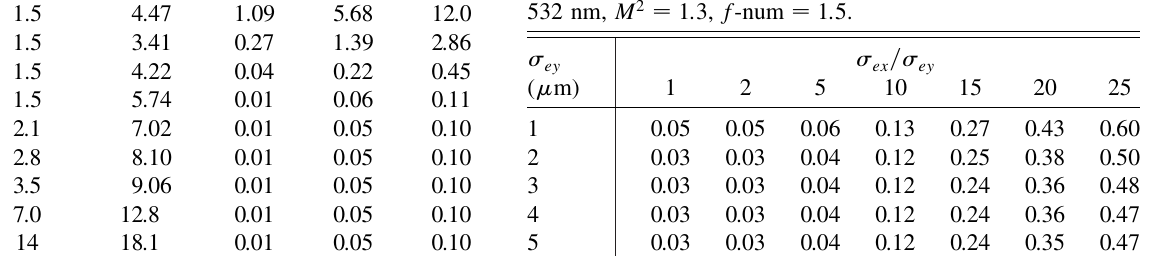
TABLE VIII. Errors for the scan of the horizontal dimension (cid:1) 1 (cid:3) m . The =(cid:2) (cid:2) for various aspect ratios (cid:2) when (cid:2) ex ex ey ey f -numbers are chosen so that the angular scanning range can be limited to 1 mrad; the f -number used is given by whichever is the greater of 1.5 and the value given by Eq. (36). The laser properties assumed are (cid:13) (cid:1) 532 nm and M 2 (cid:1) 1 : 3 . TABLE IX. The factor a electron beam sizes of interest at the ILC. Laser wavelength